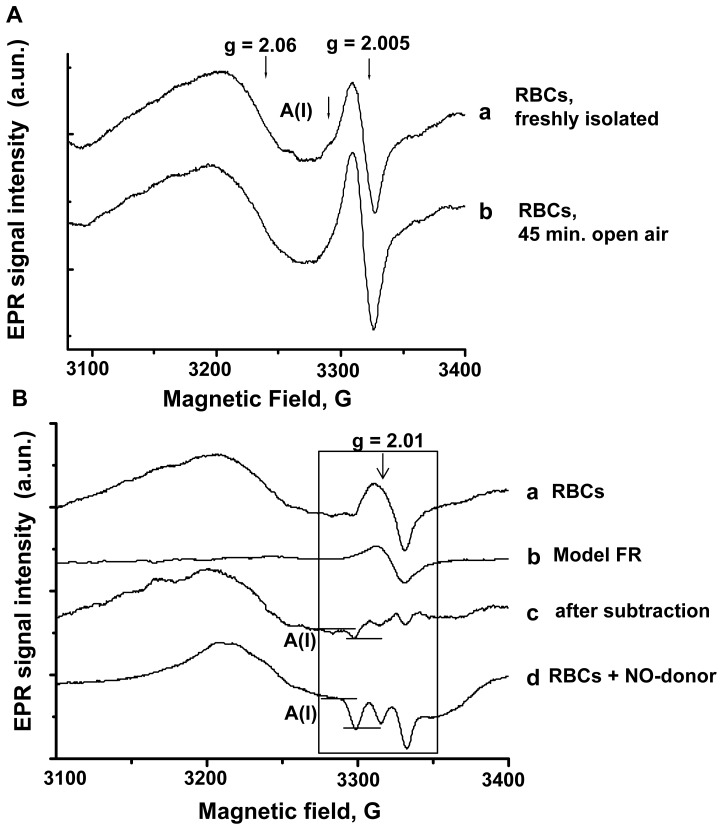
Quantification of Hb-NO from human venous erythrocytes.(A) Typical EPR spectra of RBCs, frozen after blood centrifugation (a), and after 45 minutes of exposure to air (b) (diapason: 3100–3400 Gauss). (B) Final EPR spectrum of RBCs (c, gain = 6.2×104), after subtraction of the model spectrum of free radicals (b), divided by the correspondent proportional scale factor, from the EPR spectrum of the initial sample frozen immediately (a). Typical EPR spectra of RBCs, frozen after incubation under low O2 level with the NO-donor, Dea-NONOate (50 µmol/L; c, gain = 3.1×104). A peak-to- peak amplitude of hf component, A(I), of the HbNO triplet structure attributed to 5-coordinate α-HbNO was used for quantitation.